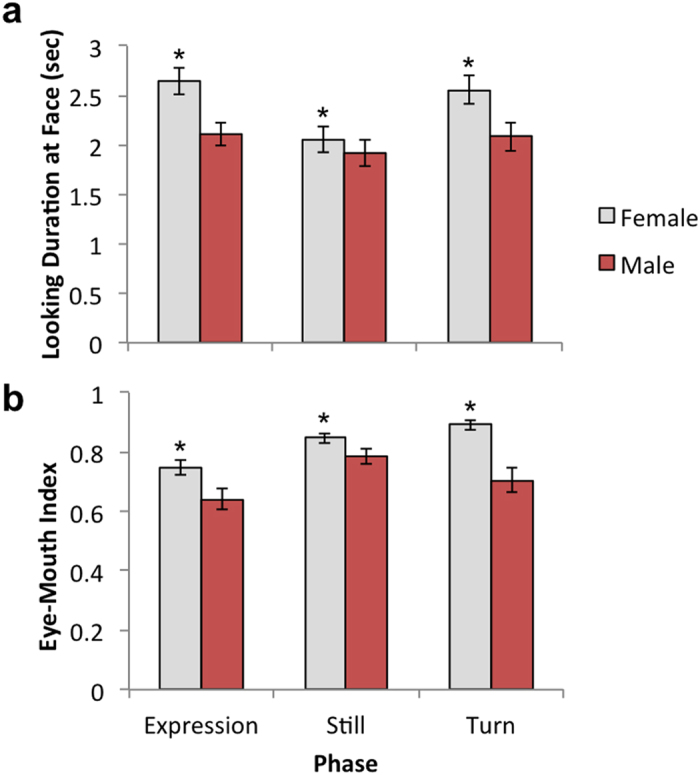
Eye tracking task results.Across both measures, there were main effects of sex: females (gray) > males (red), *ps < 0.05. Error bars reflect standard error of the mean. (a) Look durations to faces. (b) The eye-mouth index (EMI) reflects the relative amount of time looking to the eye and mouth regions of the face, with values of .50 indicating equal looking to eyes and mouth, and values above .50 indicating more looking to the eyes.